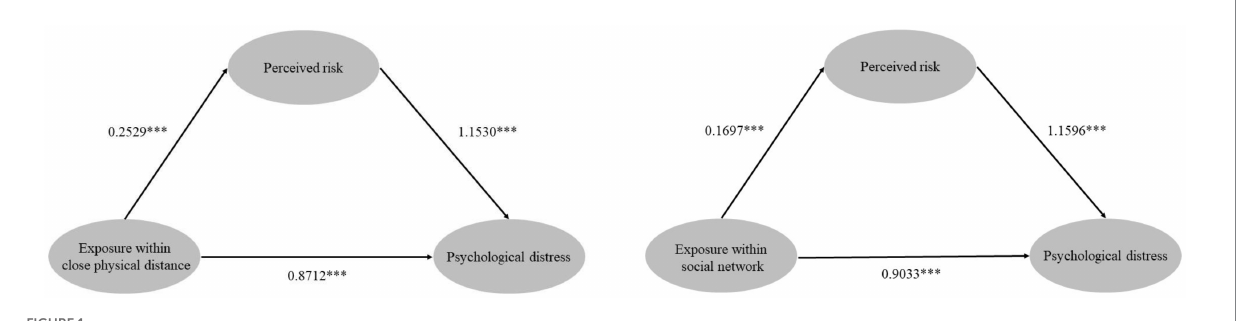
FIGURE 1 The mediating effect of perceived risk between exposure within a close physical distance/exposure within the social network and respondents’ psychological distress (*** p < 0.001).